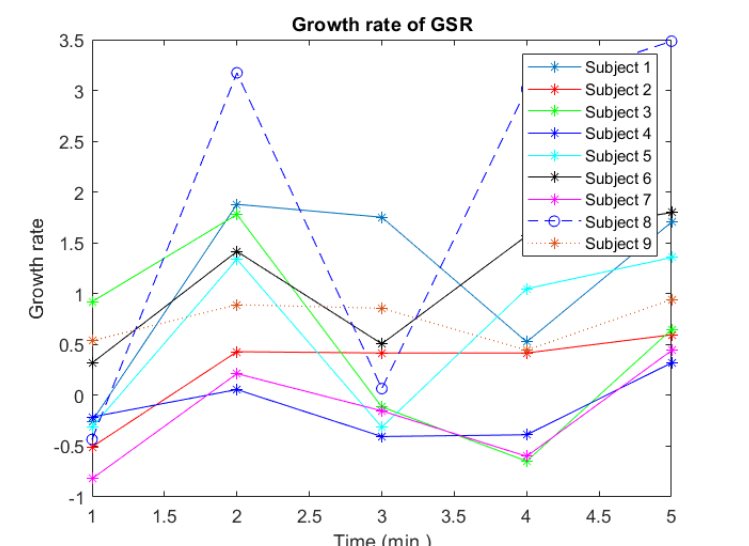
Figure 9. Experiment 2 growth rate of GSR.